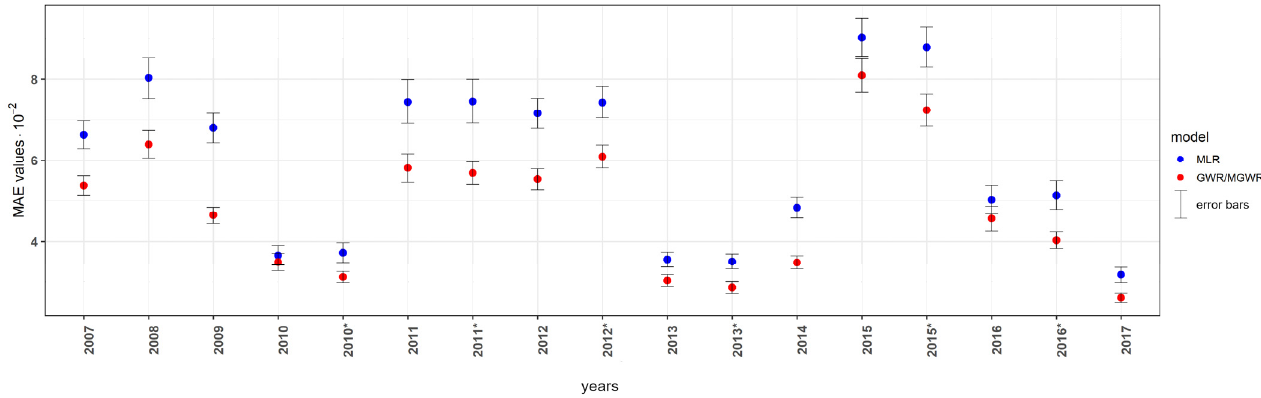
Figure 4. MAE values and MAE error bars for individual years. The asterisk means that the model was built on two selected variables (BOUFORIND and ROADLOC), and not based on the stepwise variable selection method. Note the units on the y -axis.